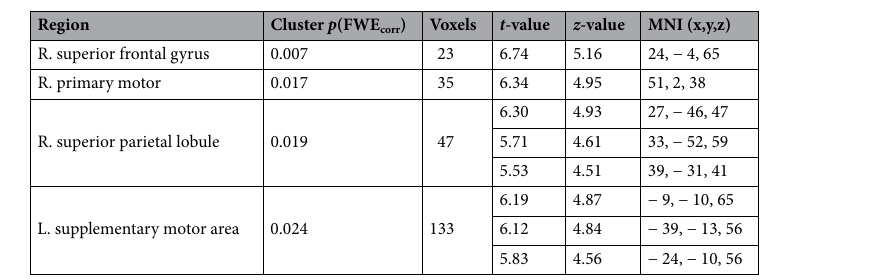
Table 4. Brain regions where decreases connectivity of the PPI Learning contrast from the thalamus correlates with increased plasma escitalopram levels. Results shown at p < 10 –5 cluster forming threshold corrected with family-wise error (FWE) on the cluster level (≥ 20 voxels). L left, R right, peak MNI Montréal Neurological Institute coordinates, FEW family-wise error.